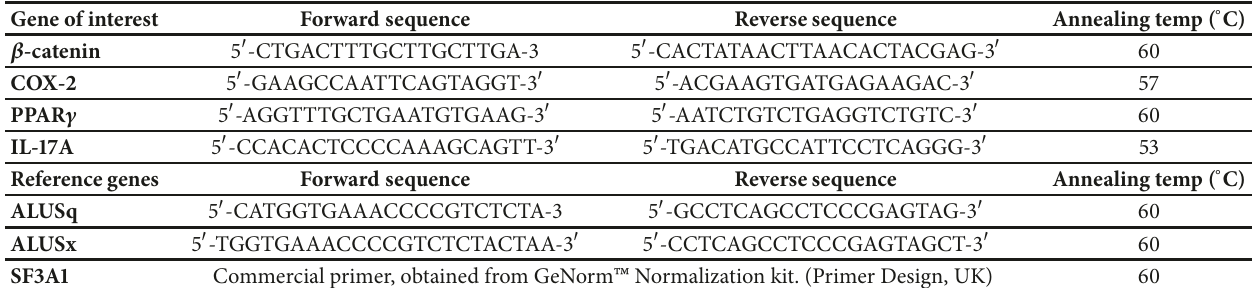
Table 1: Forward and reverse sequences of primers for all genes and their annealing temperatures.